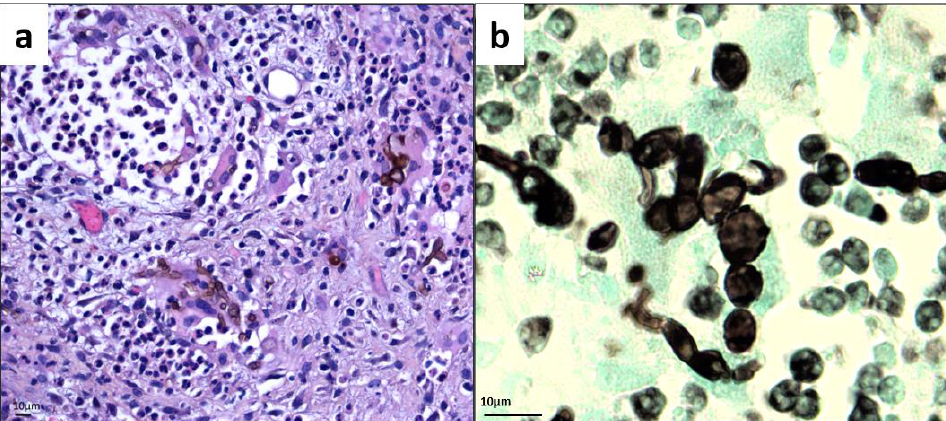
Figure 2. Histology of skin biopsy ( a ) Hematoxylin Eosin Safran stain (magnification ×500). ( b ) Gomori – Grocott stain showing bloated hyphae and chain-organized muriform cells characterized by a round to polyhedral (chestnut) shape, 5 to 12 mm in diameter, with a thick wall, a dark pigment, and both transverse and longitudinal cross-walls (magnification ×1000).